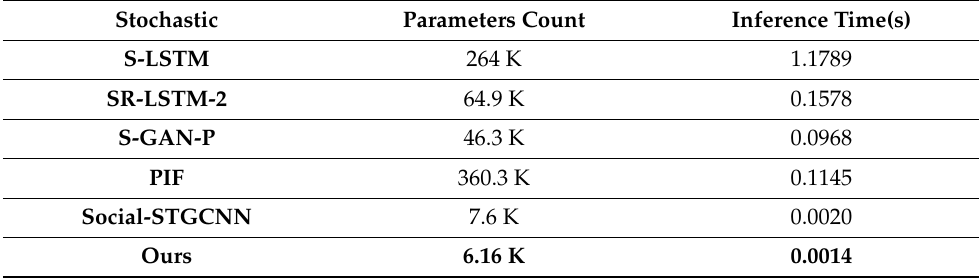
Table 2. A comparison table of each model’s parameters and inference speed.